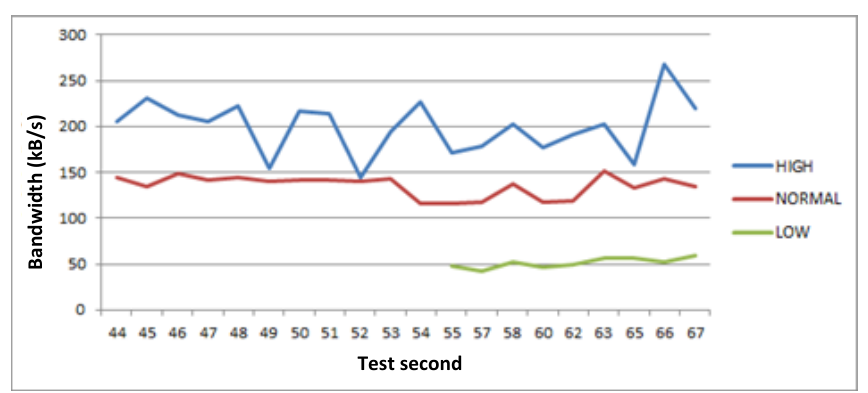
Figure 6. Low priority request